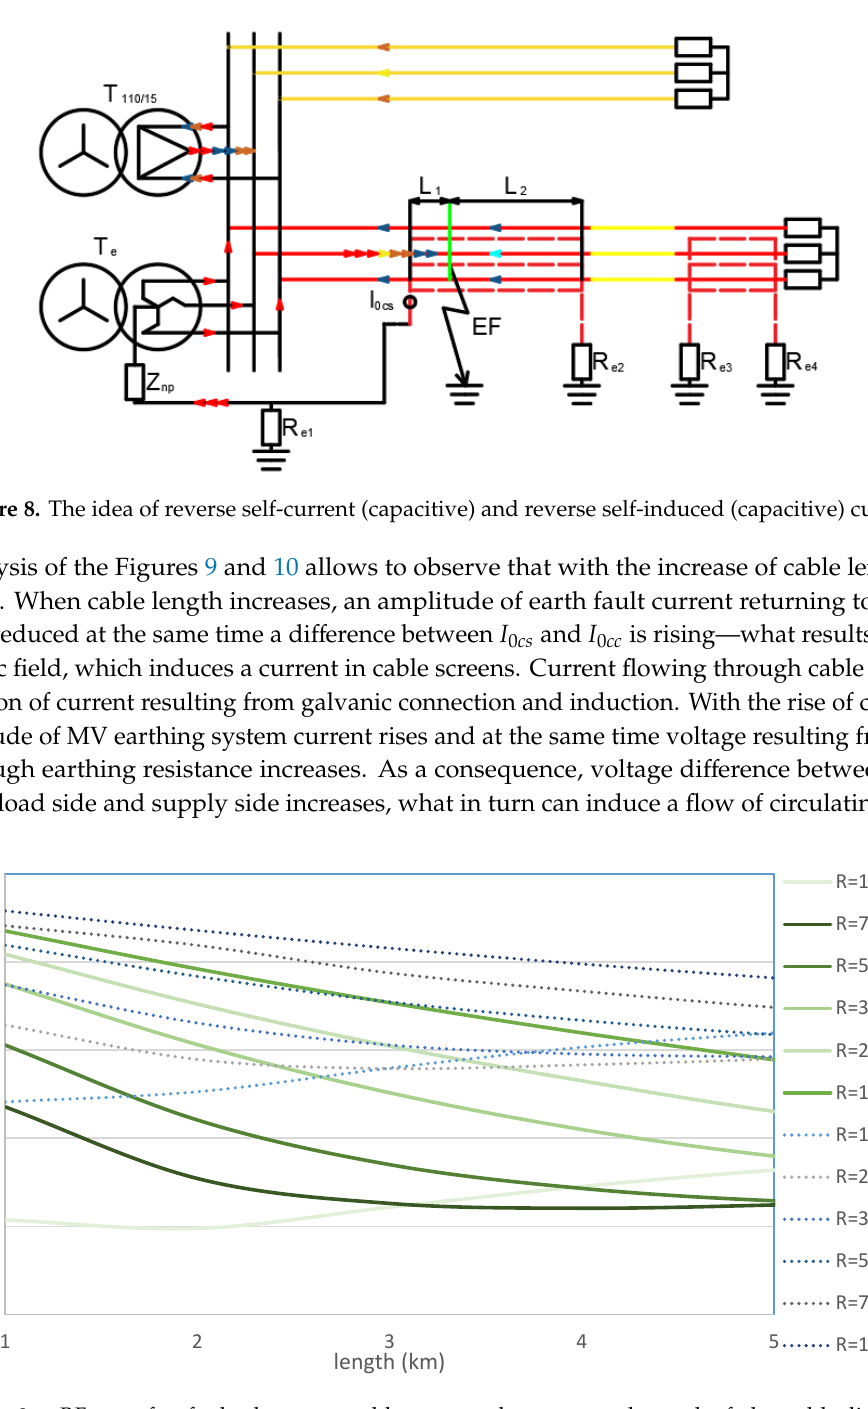
Figure 9. RF 110/15 for faults between cable core and screen at the end of the cable line in a trefoil Figure 9. RF 110 / 15 for faults between cable core and screen at the end of the cable line in a configuration. trefoil